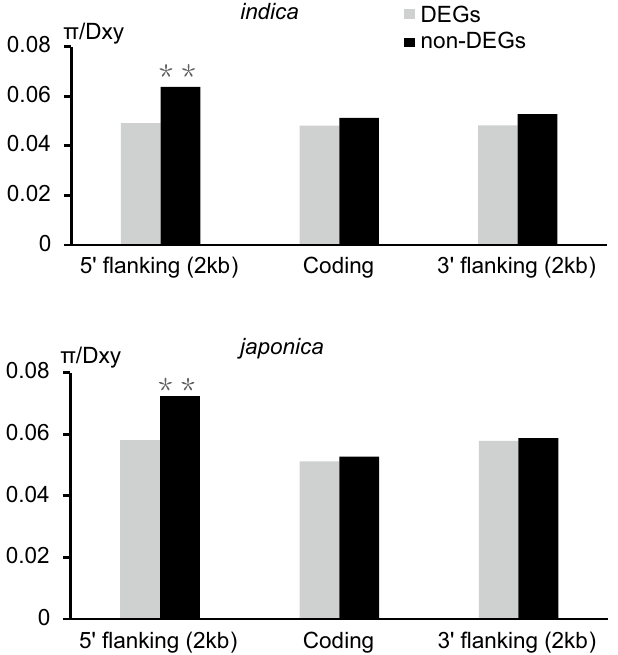
Figure 7. Polymorphism and divergence in gene-coding and regulatory regions of genes in indica and japonica rice. Y-axis indicates the ratio of polymorphism to divergence (π/Dxy), and bars in the x-axis represent the 5 ′ regulatory regions, gene-coding regions and 3 ′ regulatory regions of genes. The grey blocks indicate the DEGs, and the black blocks represent the non-DEGs. ** indicates P-value < 0.05. This figure was created using Microsoft Excel 2013 and Adobe Illustrator